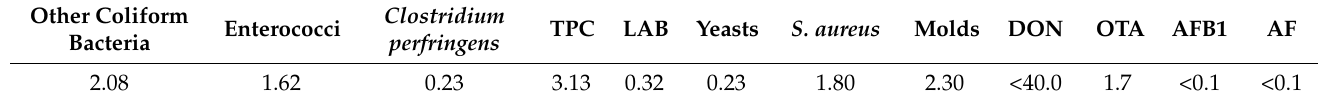
Table 5. Mealworm meal microbial (log CFU) and mycotoxins (mg/kg) analyses.